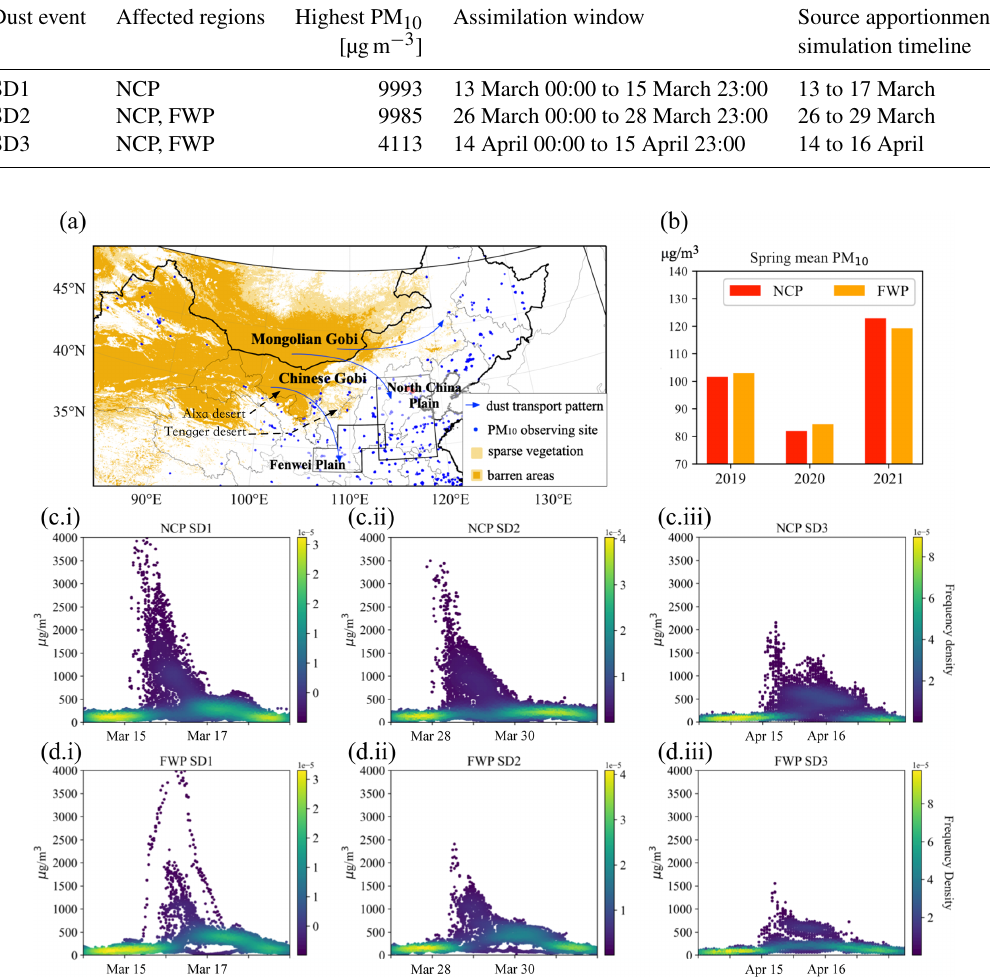
Figure 1. (a) Distribution of the potential dust emission source (barren and sparse vegetation land cover) over East Asia and the China MEP observing network over northern China. (b) The spring (March–May) mean PM 10 concentration observations over NCP and FWP from 2019 to 2021. Time series of the hourly PM 10 concentration measurements reported by stations in NCP (c) and FWP regions (d) during SD1 (i) , SD2 (ii) , and SD3 (iii)